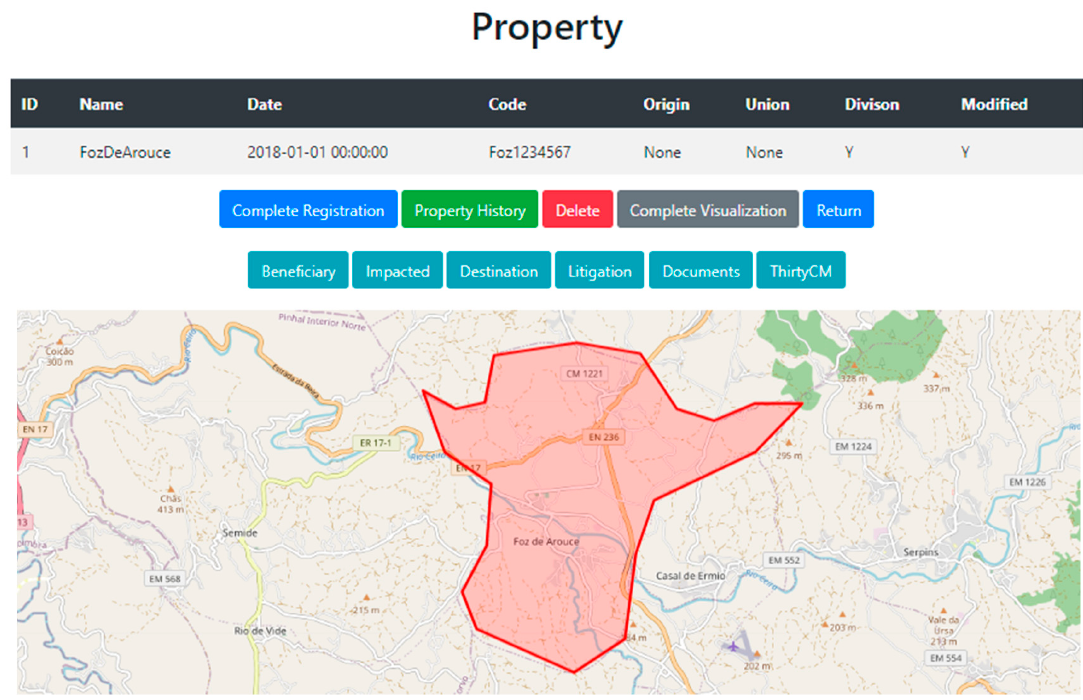
Figure 4. Visualization of a property.